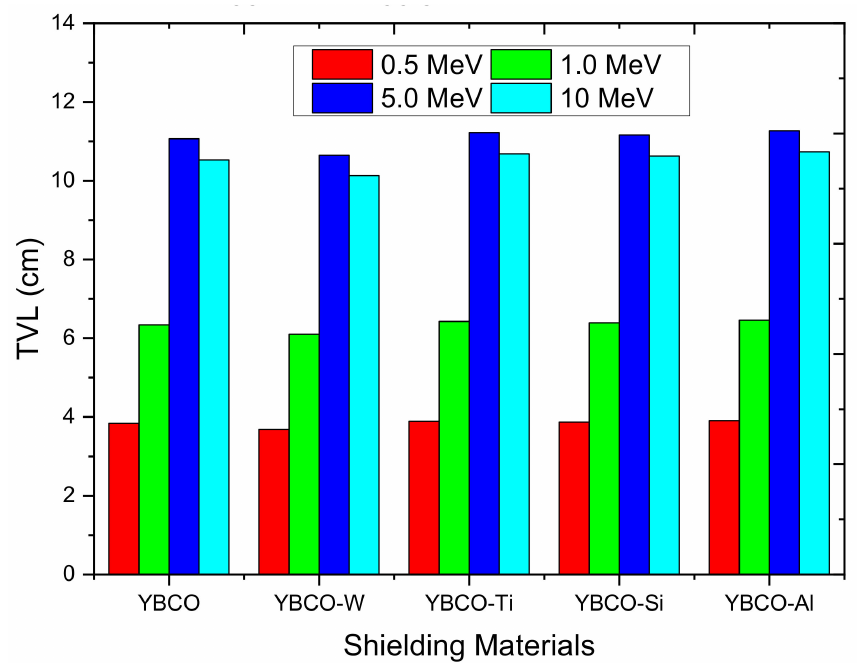
Figure 8. The tenth value layer for the produced ceramics at 0.5, 1, 5, and 10